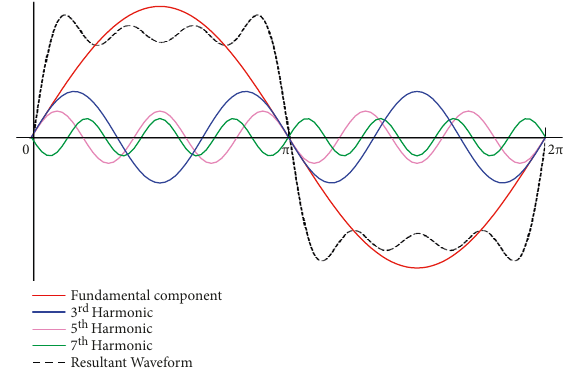
Figure 1: Distorted waveform and its constituent Fourier